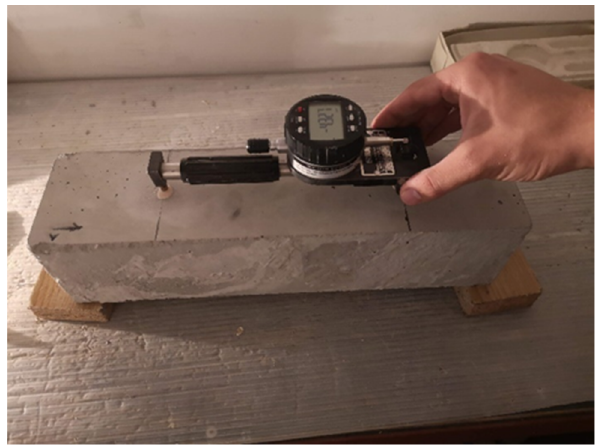
Figure 2. Measurement of the length change on the concrete prism.